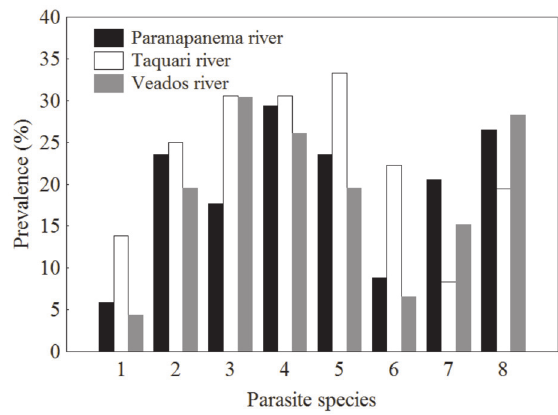
Figure 3 - Prevalence of eight parasite species shared by Leporinus friderici populations in three upstream tributaries of Jurumirim reservoir, Upper Paranapanema River, southeast, Brazil. (1 = Dactylogyridae gen. sp. 1; 2 = Jainus piava ; 3 = Jainus sp.; 4 = Tereancistrum sp.; 5 = Urocleidoides sp. 1; 6 = Urocleidoides sp. 2; 7 = P .( S .) amarali ; 8 = P .( S .) iheringi ).